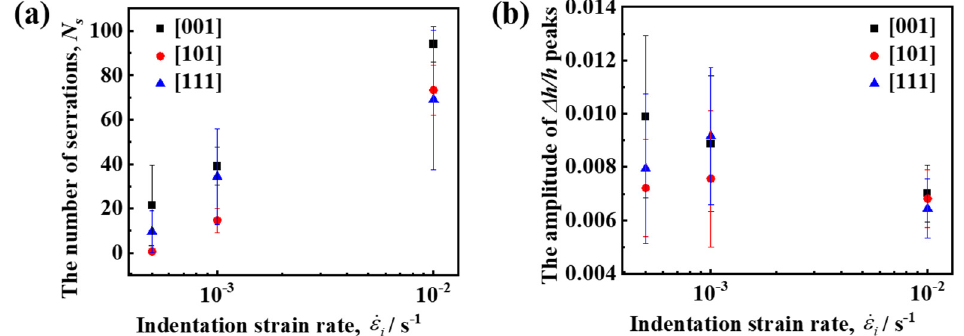
Figure 4. The evolutions of ( a ) the number of serrations and ( b ) the amplitude of ∆ h / h peaks with indentation strain rate from the CSR tests in the [001]-, [101]- and [111]-oriented grains. The rate dependence of hardness was evaluated based on the hardness obtained at the maximum load (i.e., P = 1000 mN) as shown in Figure 5, which is free of indentation . ε i = 10 − 3 − 10 − 1 s − 1 , range of indentation strain rates for nSRS at the [001] orientation is: . ε i = 10 − 2 − 10 − 1 s − 1 . The range for nSRS at the [111] while that for the [101] orientation is: